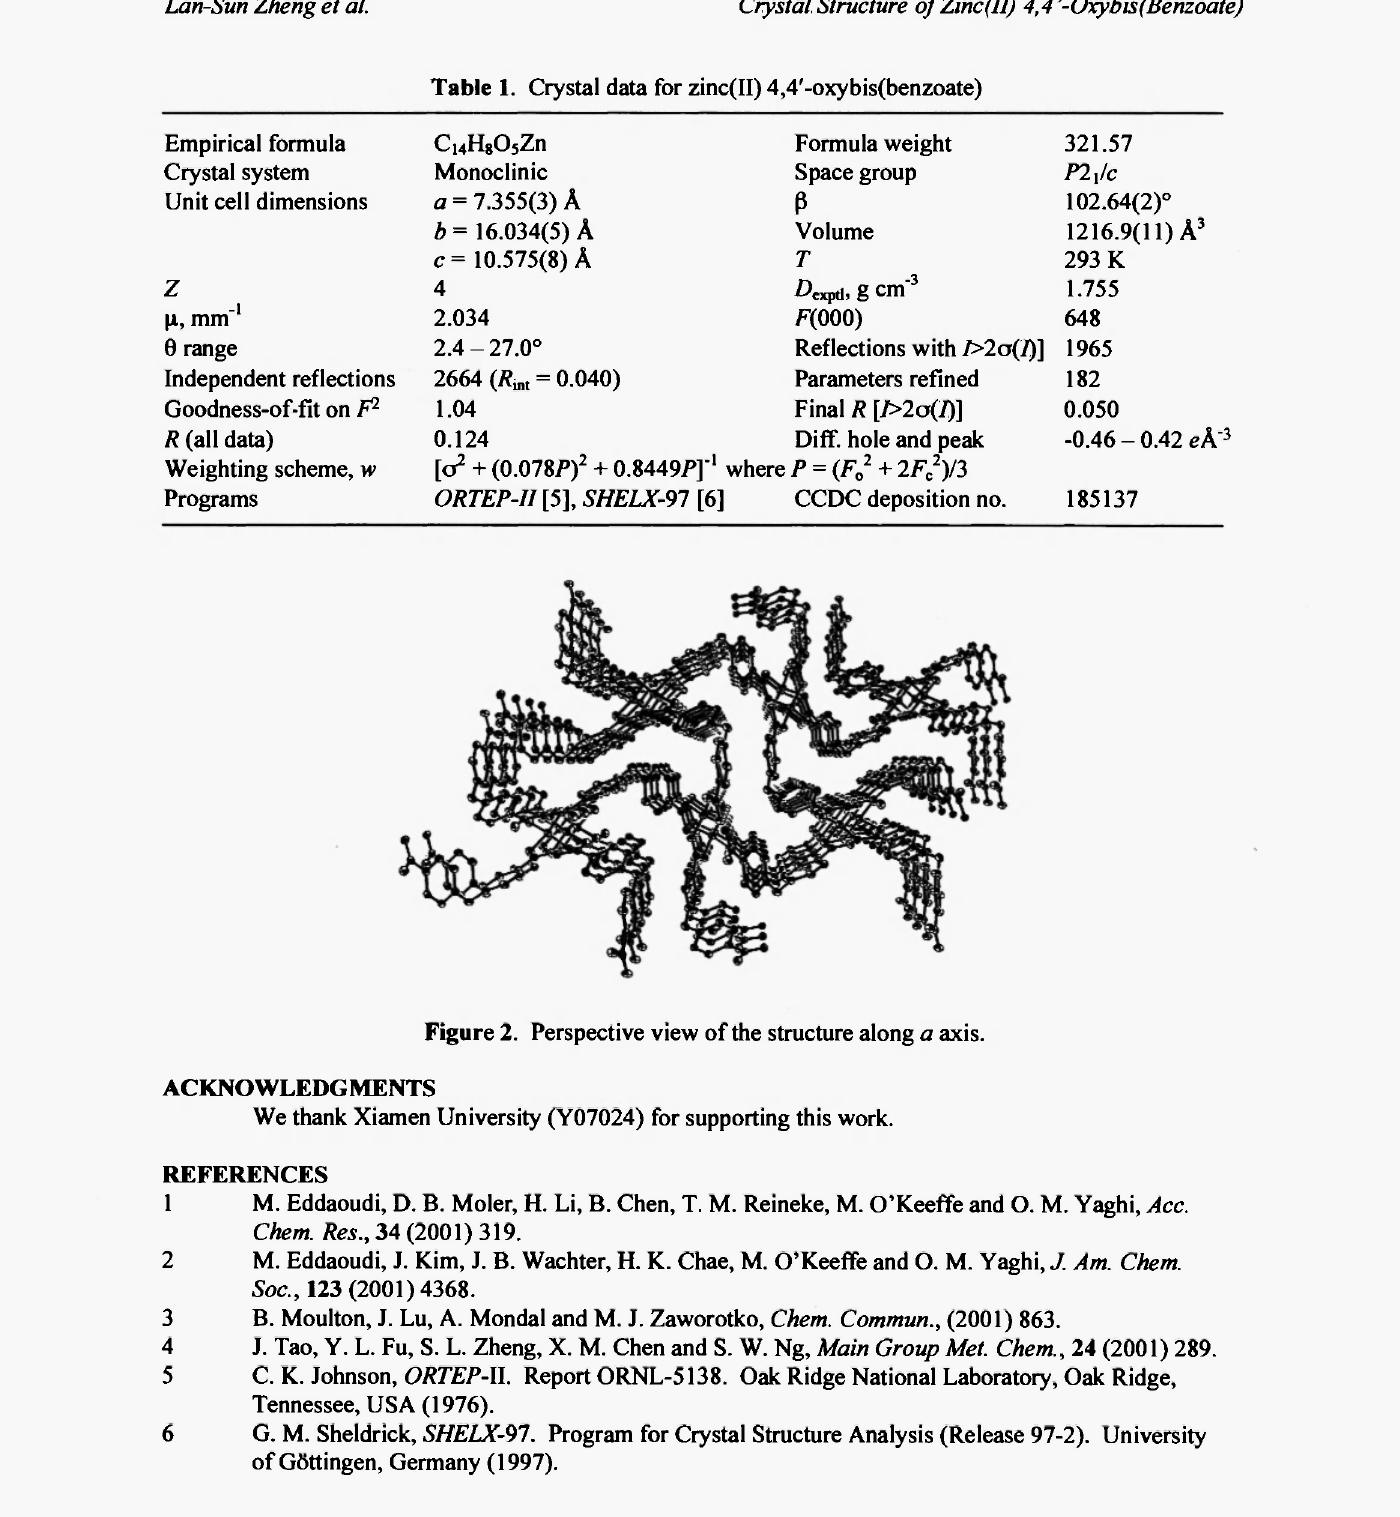
Table 1. Crystal data for zinc(II) 4,4'-oxybis(benzoate)